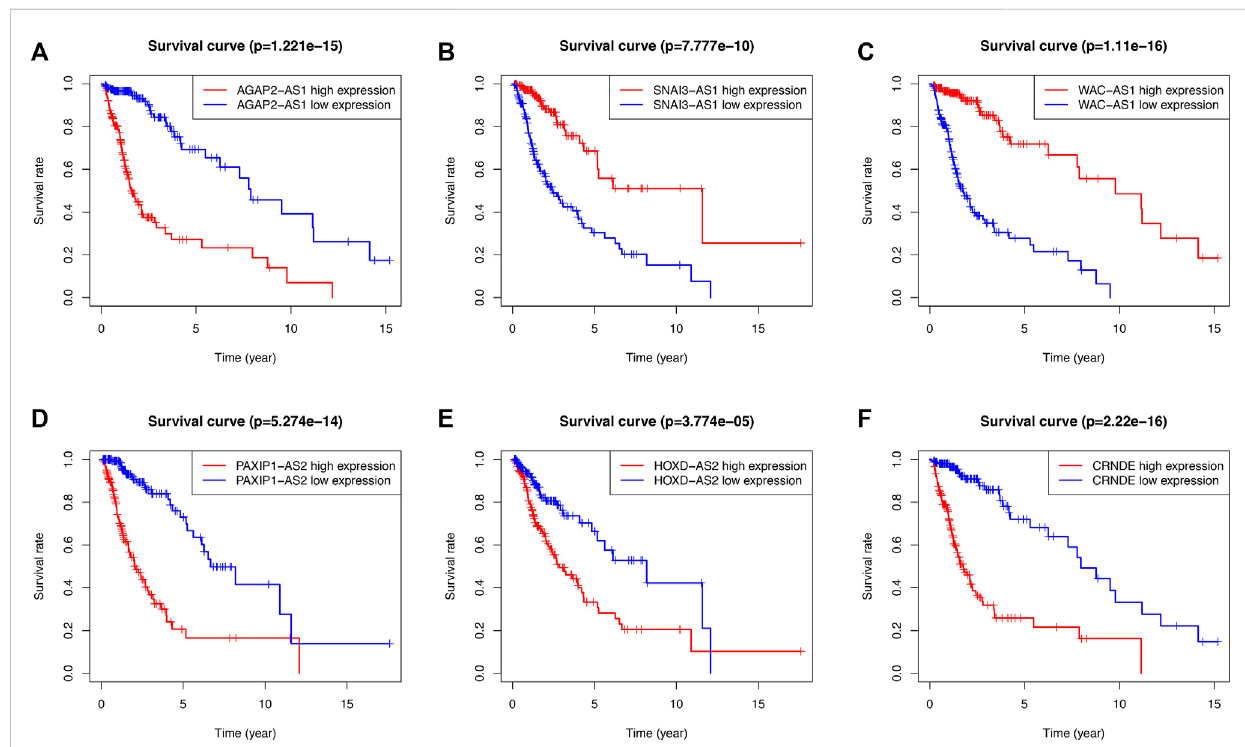
FIGURE 3 The prognostic signature of SRlncRNA K-M curves in the training cohort. (A – F) K-M survival curves for CRNDE, AGAP2-AS1, HOXD-AS2, and PAXIP1-AS2showedthatthehighexpressiongrouphadworseOS,whereastheK-McurvesforSNAI3-AS1andWAC-AS1showedthatthehighexpression group had better